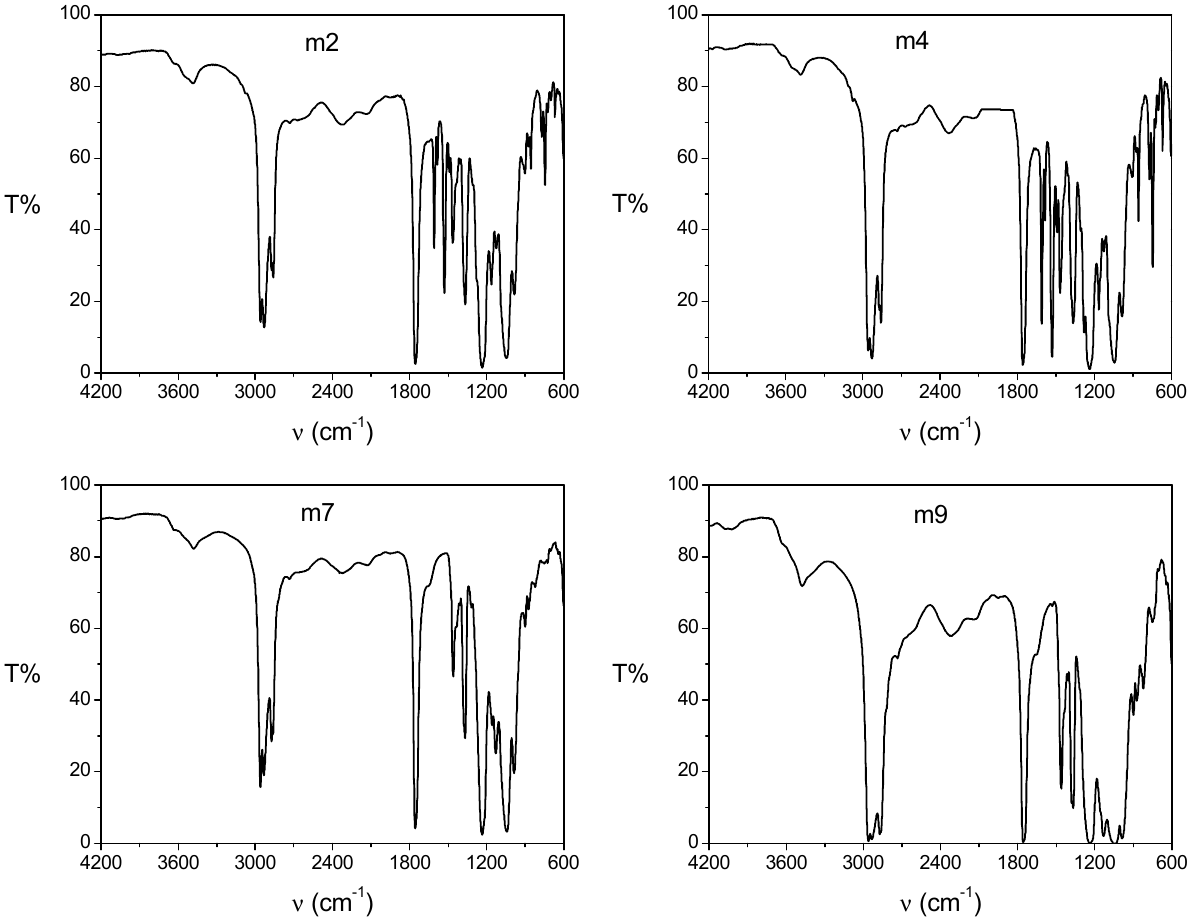
Figure 4. FTIR spectra of PIMs m2, m4, m7, and m9 with compositions indicated in Table 6. The IR spectra for the m2 and m4 PIMs were practically the same because they had the same components (CTA, 2NPOE, Ionquest ® 801) with the only difference that the bands that appear in the region of 1400 to 1600 cm − 1 were more intense for the m4 sample, most likely because it contained a greater amount of 2NPOE. The IR spectra for both m2 and m4 PIMs showed characteristic bands for each of the components present. For the spectra of the membranes with CTA–2NPOE–Ionquest ® 801, bands at 2958, 2930, 2859, and 2873 cm − 1 were observed and assigned to the characteristic vibrations of CTA C–H bonds or also to –CH2– of the aliphatic chain of 2NPOE; the band at 1755 cm − 1 is characteristic of a carbonyl group C=O of CTA, the signal at 1528 cm − 1 is characteristic of the NO 2 group of the plasticizer, while the band at 1367 cm − 1 confirmed the vibrations of C-H bonds in CTA. The band at 1235 cm − 1 is another characteristic band of 2NPOE associated with the vibration of the R–O–CH 2 bond, and the bands associated with Ionquest ® 801 are 1047 cm − 1 with an attached signal at 985 cm − 1 due to the vibration of the P–OH bond present in the